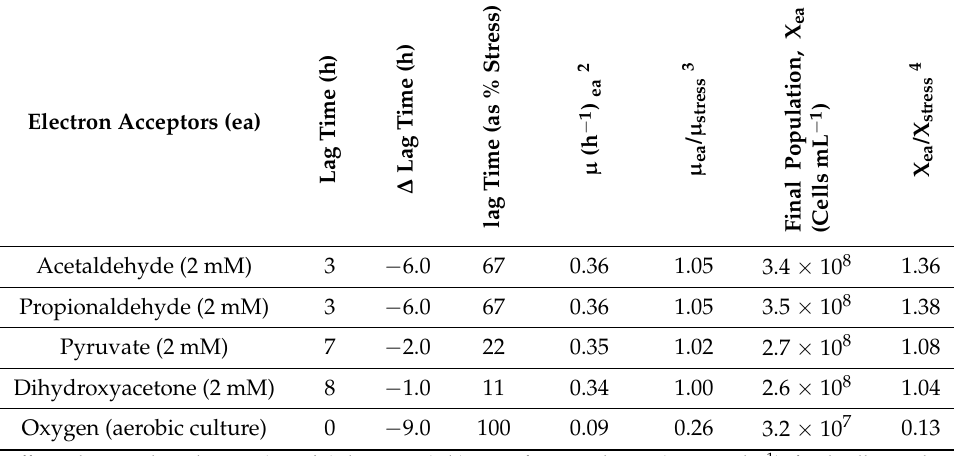
, (cid:52) , (cid:53) ethanol- (cid:51) ethanol-stressed (cid:35)